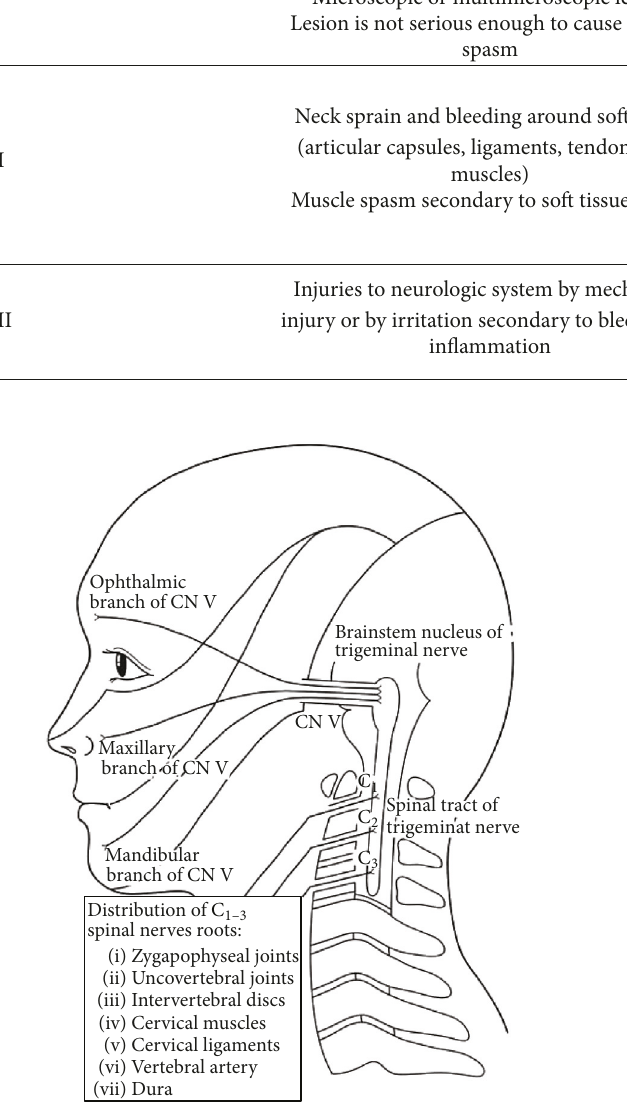
Figure 1: Schema of connection between upper spinal nerve roots and trigeminal nerve